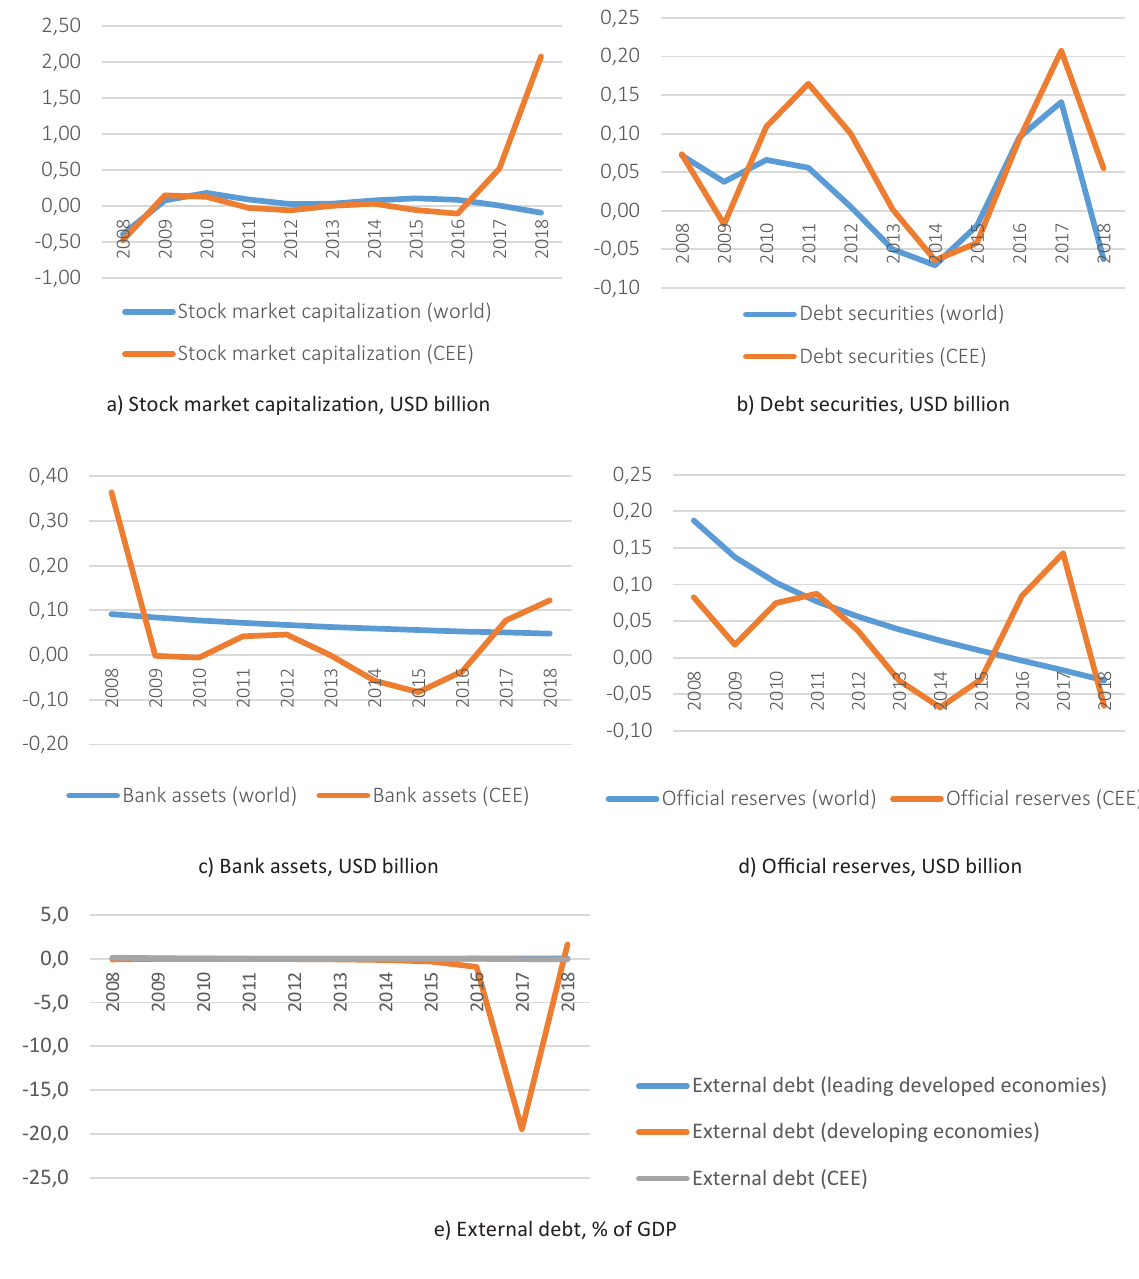
Figure 2. Dynamics of growth rates of global and regional financial indicators for approximate